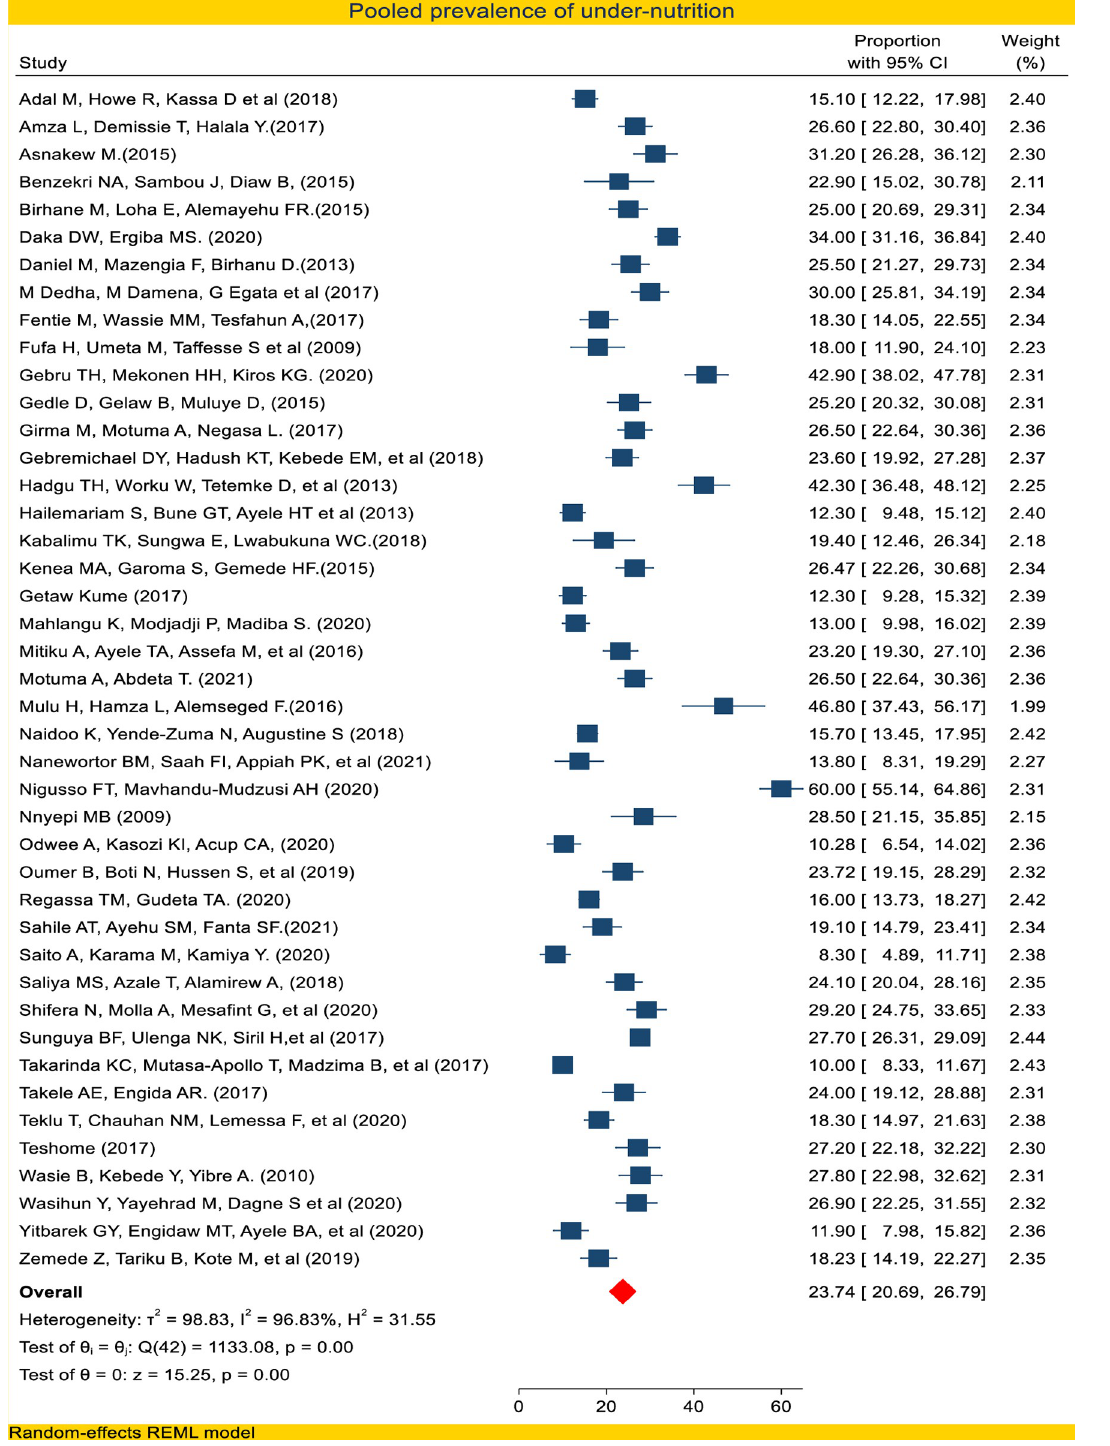
Fig 3. Forest plot of pooled prevalence of undernutrition among adult PLWHIV in sub-Saharan Africa 2021.